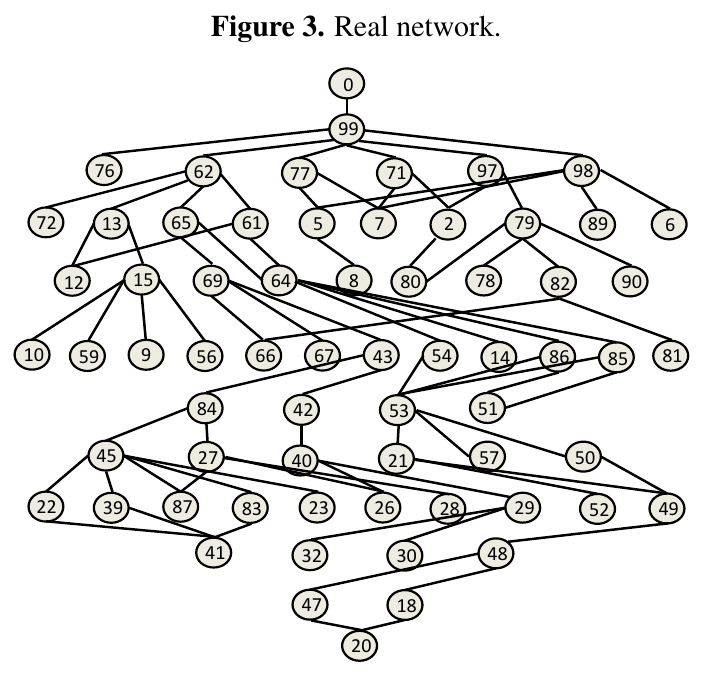
Figure 3. Real network.